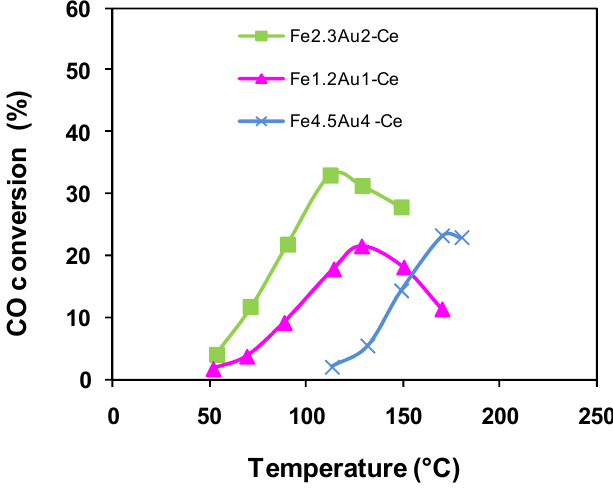
Figure 10. CO conversion as a function of reaction temperature over Au/FeO